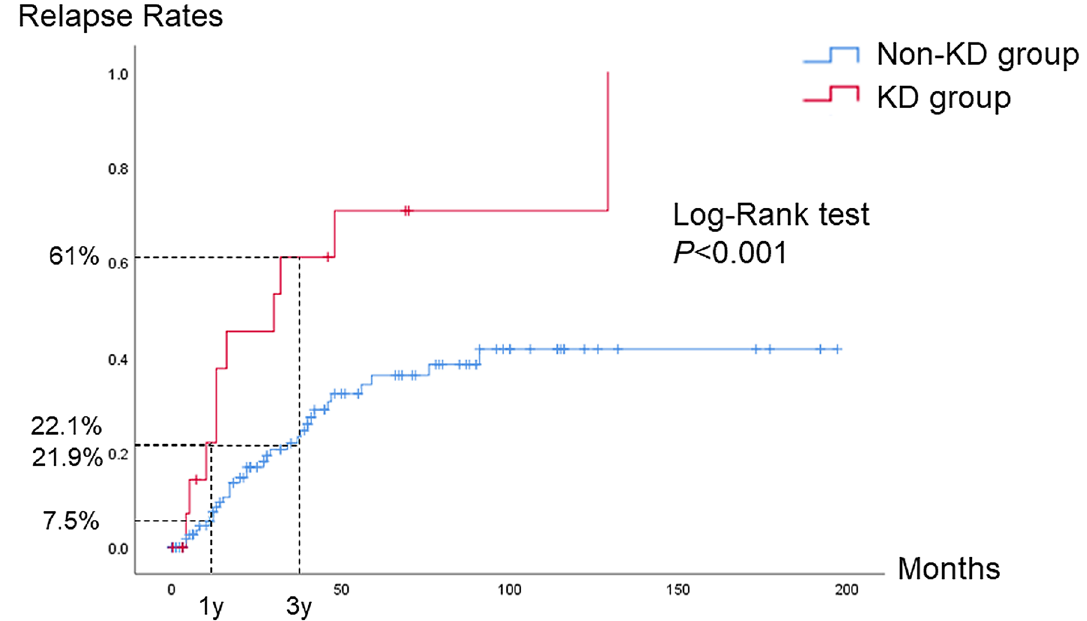
Figure 3. Cumulative relapse rates in the KD group and non-KD group.